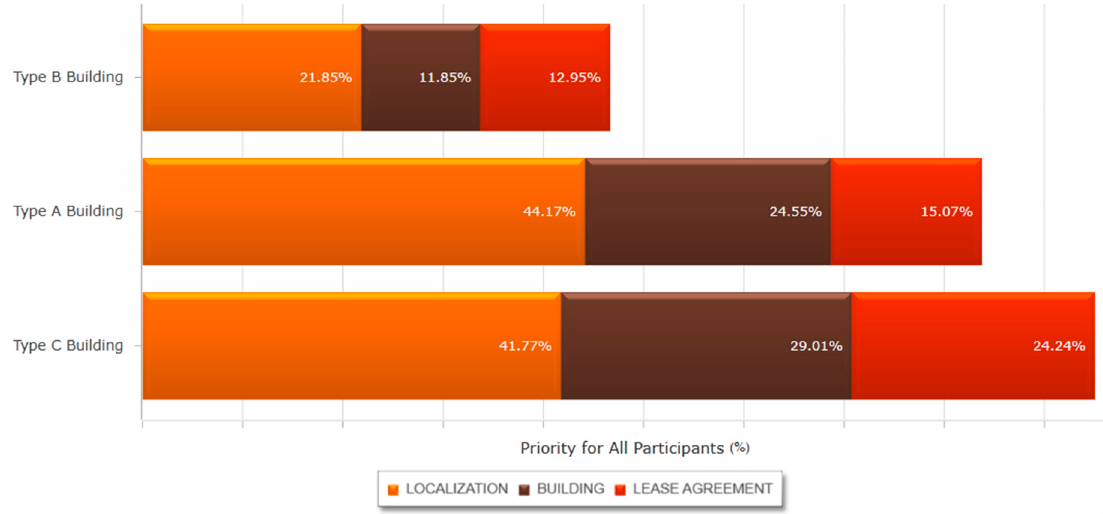
Figure 2. The hierarchy of decision alternatives (criteria sensitive, %).